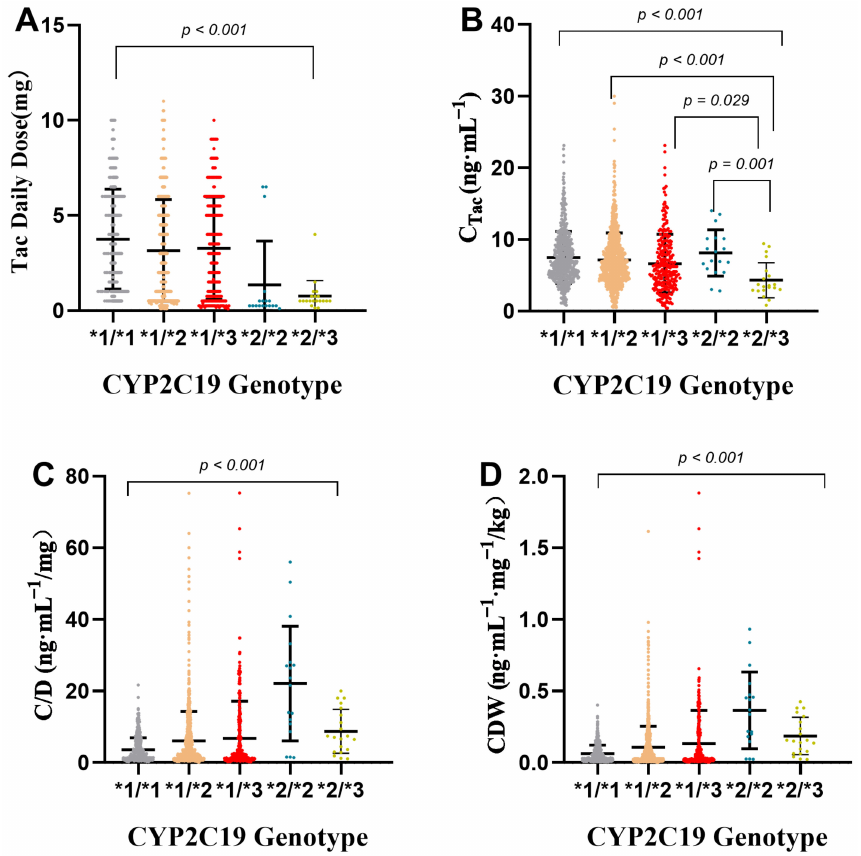
Figure 6. Effects of CYP2C19 genotypes on tacrolimus daily dose ( A ), C Tac ( B ), C/D ( C ), and CDW ( D ). p value was tested by Kruskal–Wallis test and adjusted by Dunn–Bonferroni correction; direct concentration (C Tac ), standard concentration adjusted by tacrolimus daily dose (C/D), and weight-adjusted standard concentration